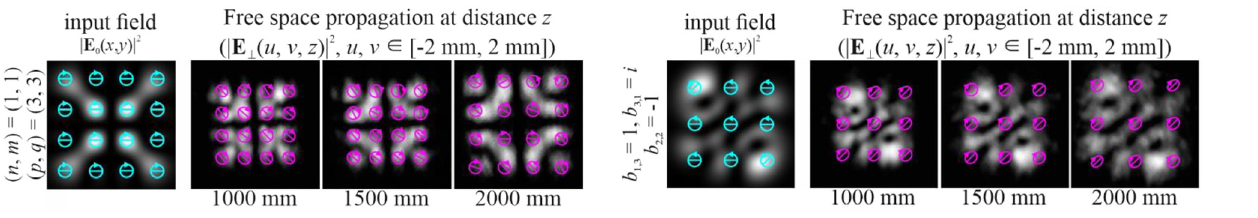
Figure 14: Experimental results for a circularly polarized multimode HG beam defined by Eq. (11) with indices satisfying the condition de fi ned by Eq. (12) (a uniformly polarized vector mode).